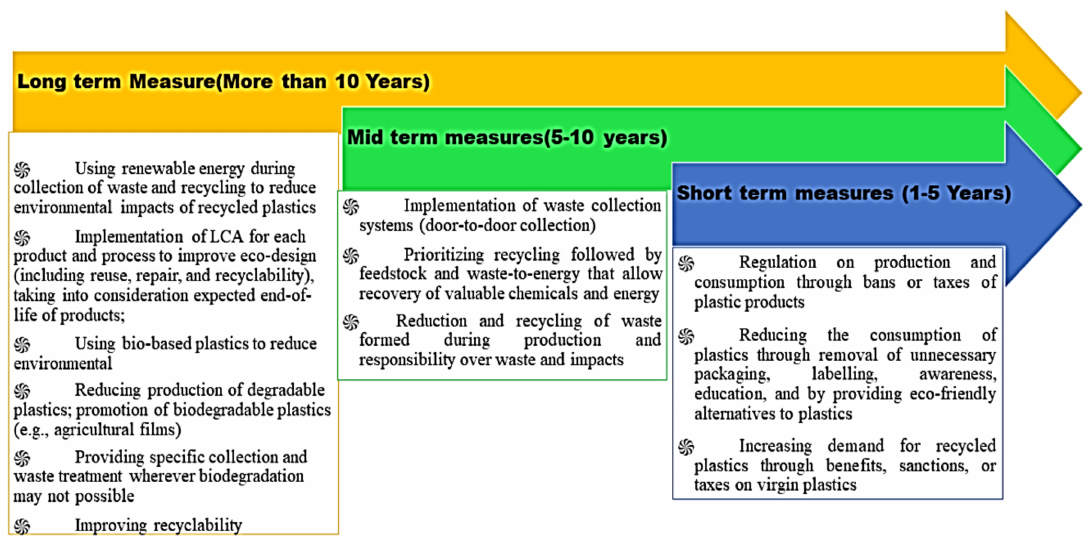
Figure 5. Classification of mitigation strategies based on time; three types of mitigation measures long-term, mid-term measures, and Short-term